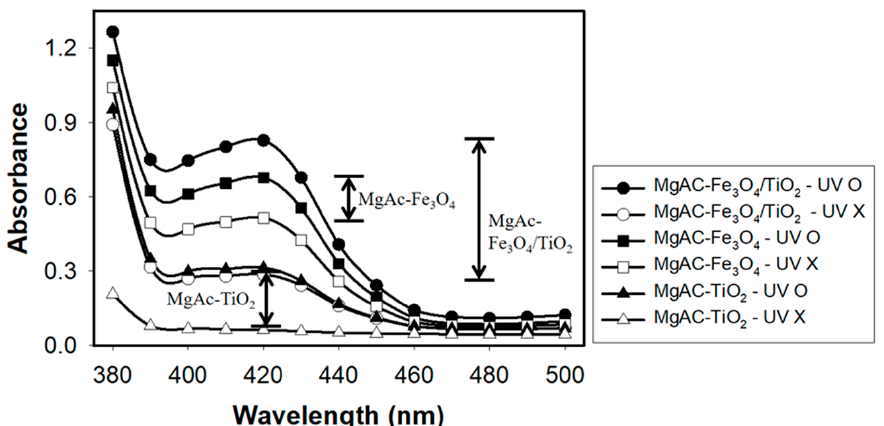
Figure 3. Absorption spectra for the oxidation of ABTS in the presence of H 2 O 2 by MgAC- Fe 3 O 4 /TiO 2 , MgAC-Fe 3 O 4 , and MgAC-TiO 2 , with or without UV-light irradiation.